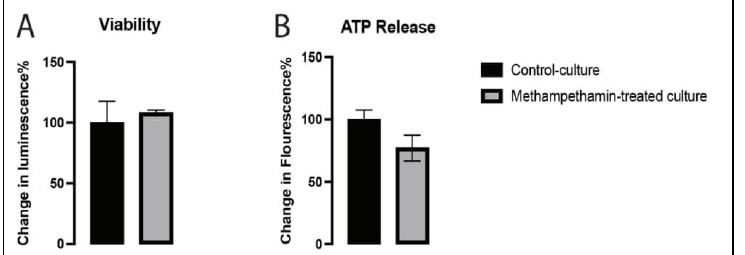
Figure 2. Effect of methamphetamine on the viability of embryonic ventral midbrain neurons (EVMNs) ( A ) and ATP release ( B ). The VMDNs on day three of culture were treated with 10 µM methamphetamine; control cultures were treated with phosphate-buffered saline (PBS). Data are expressed as mean ± SEM, n = three technical replicates, seven biological replicates (viability), and three biological replicates (ATP release). Data were analyzed using a t -test.